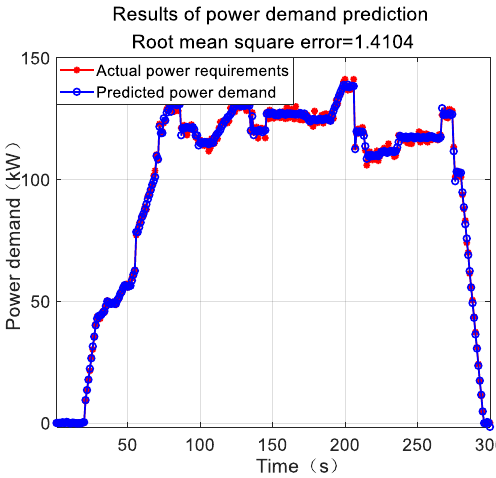
Figure 8. Power demand forecasting based on RBF-NN.